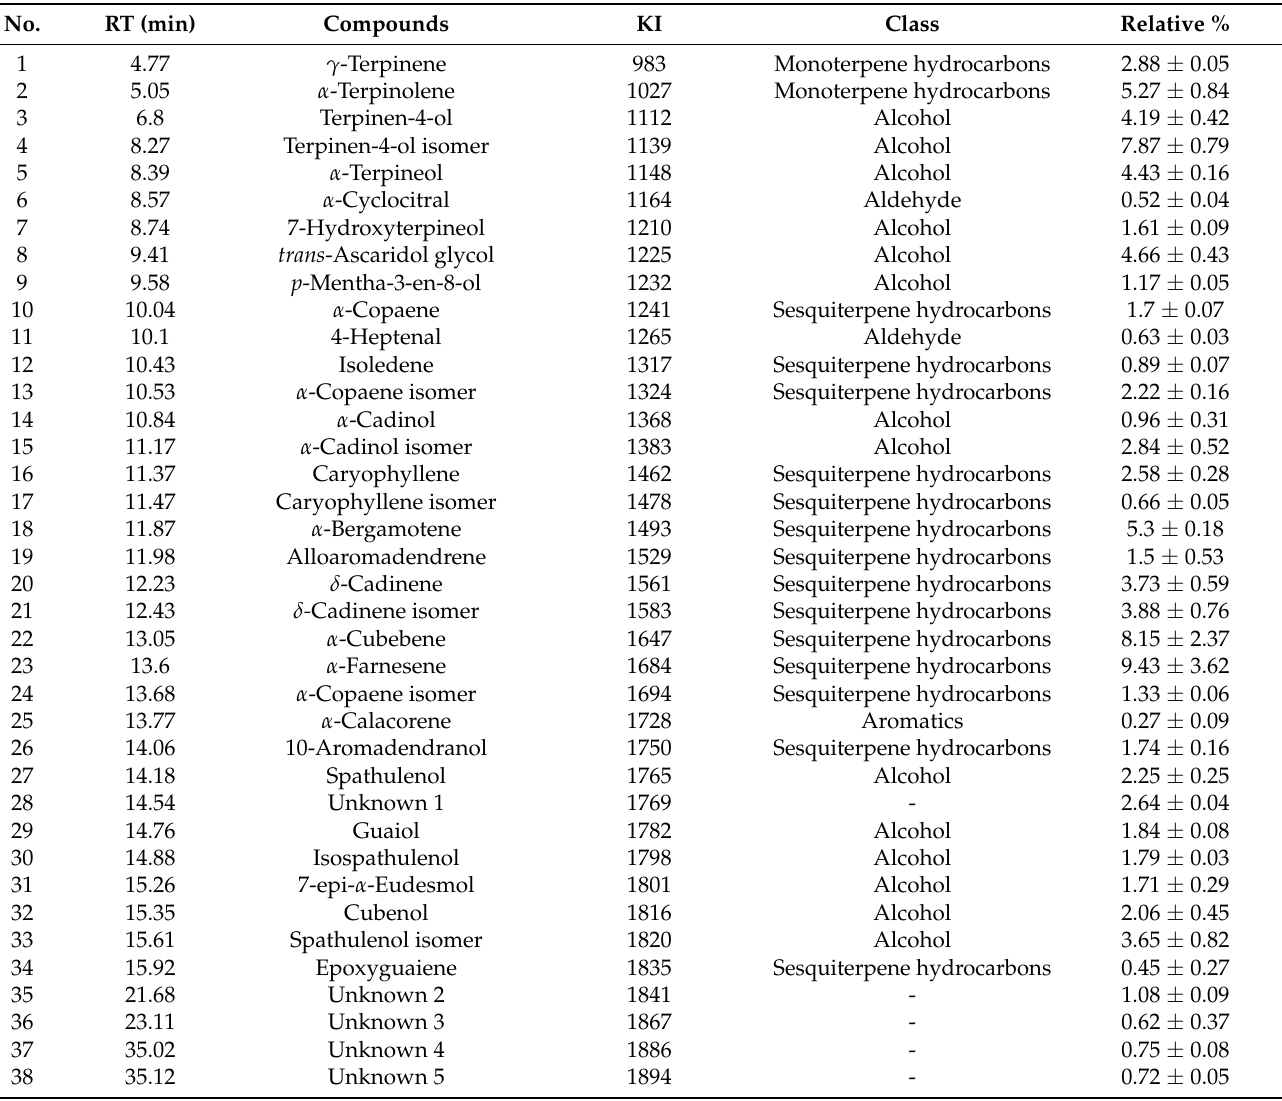
Table 1. Relative percentage of volatiles in tea tree oil specimen ( n = 3) by GC-MS